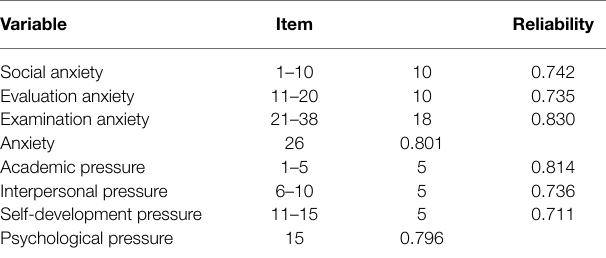
TABLE 2 | Question composition and reliability of anxiety and psychological pressure questionnaire.